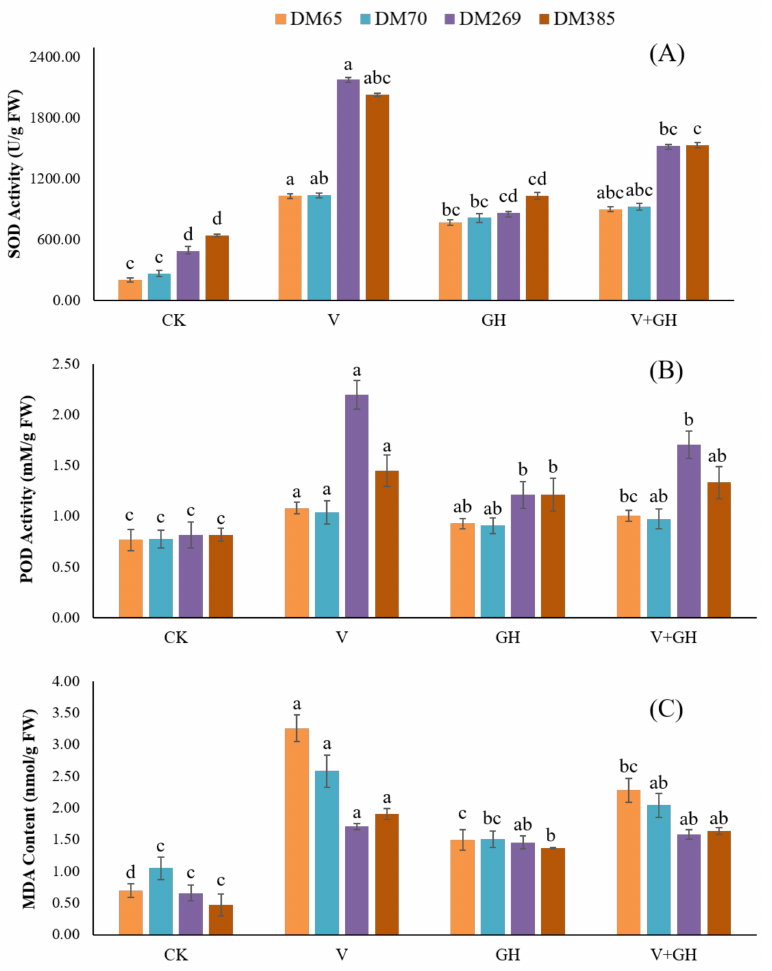
Figure 3. Effect of vernalized and greenhouse environments on the ROS scavenging enzymatic activi- ties of four barely genotypes ( n = 5). ( A ) Superoxide dismutase activity, ( B ) peroxidase activity, and ( C ) malondialdehyde content. Legends: control (CK), vernalization (V), greenhouse (GH), and moved from vernalization to the greenhouse (V + GH). Vertical bars correspond to means ± SE. Different letters indicate significant differences at p ≤ 0.05 within the genotypes and among the